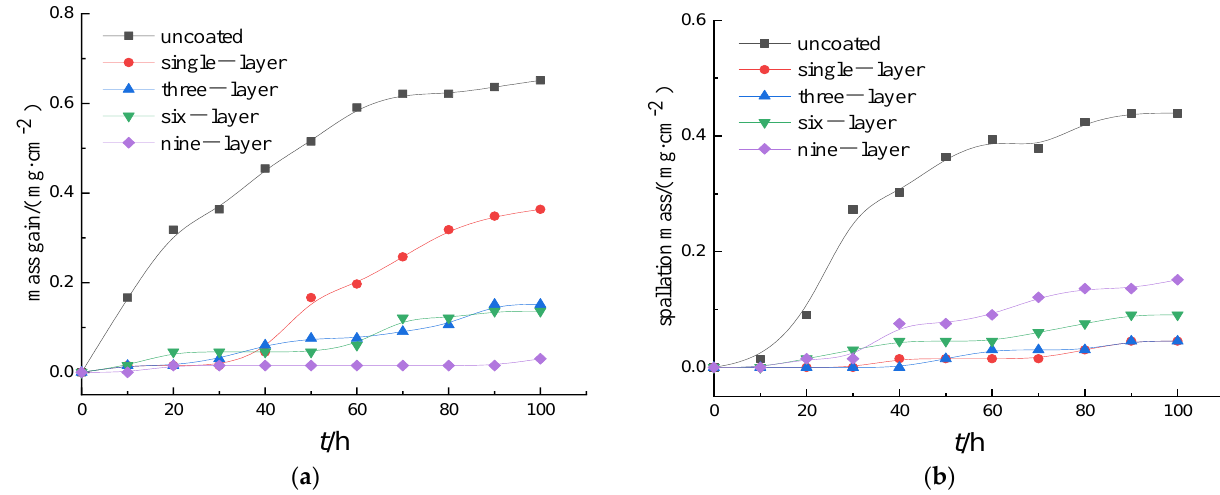
Figure 3. Oxidation kinetics curve of uncoated sample and mullite film samples with different layers at 900 °C in air: ( a ) mass gain; ( b ) spallation mass.